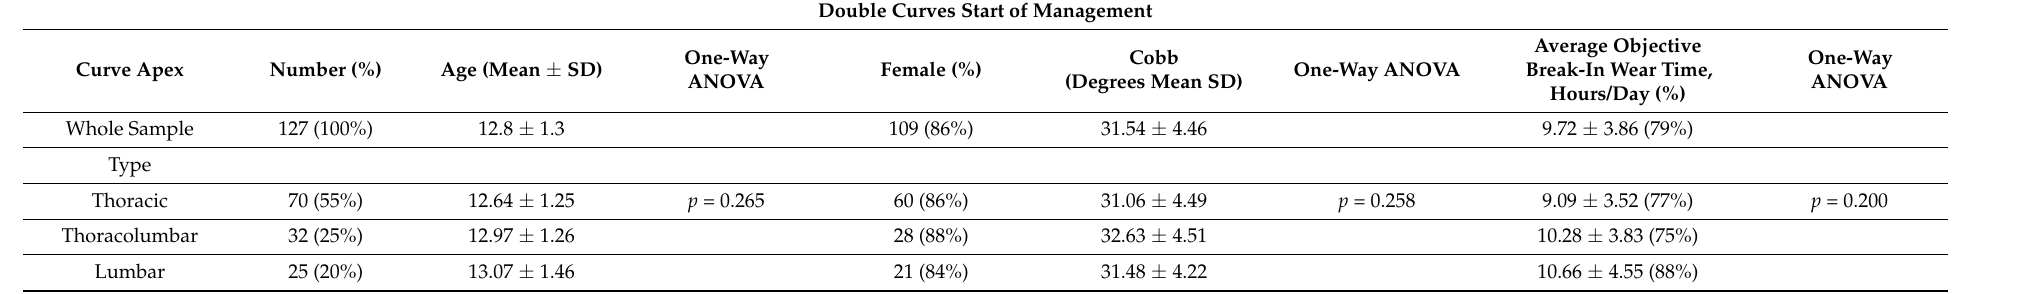
Table 2. Double-curve breakdown at the start of